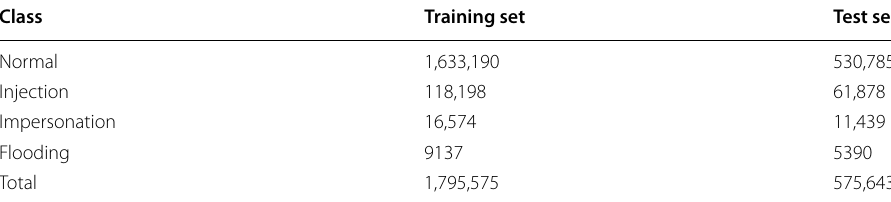
Table 5 Information about the samples of AWID